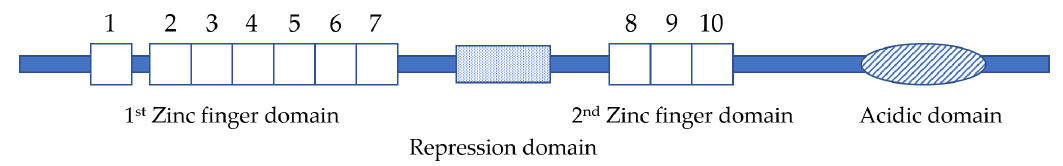
Figure 1. EVI1 protein structure. The numbered boxes indicate individual zinc fingers. The dotted box indicates the proline-rich repression domain. The oval indicates the acidic domain. indicates the proline-rich repression domain. The oval indicates the acidic